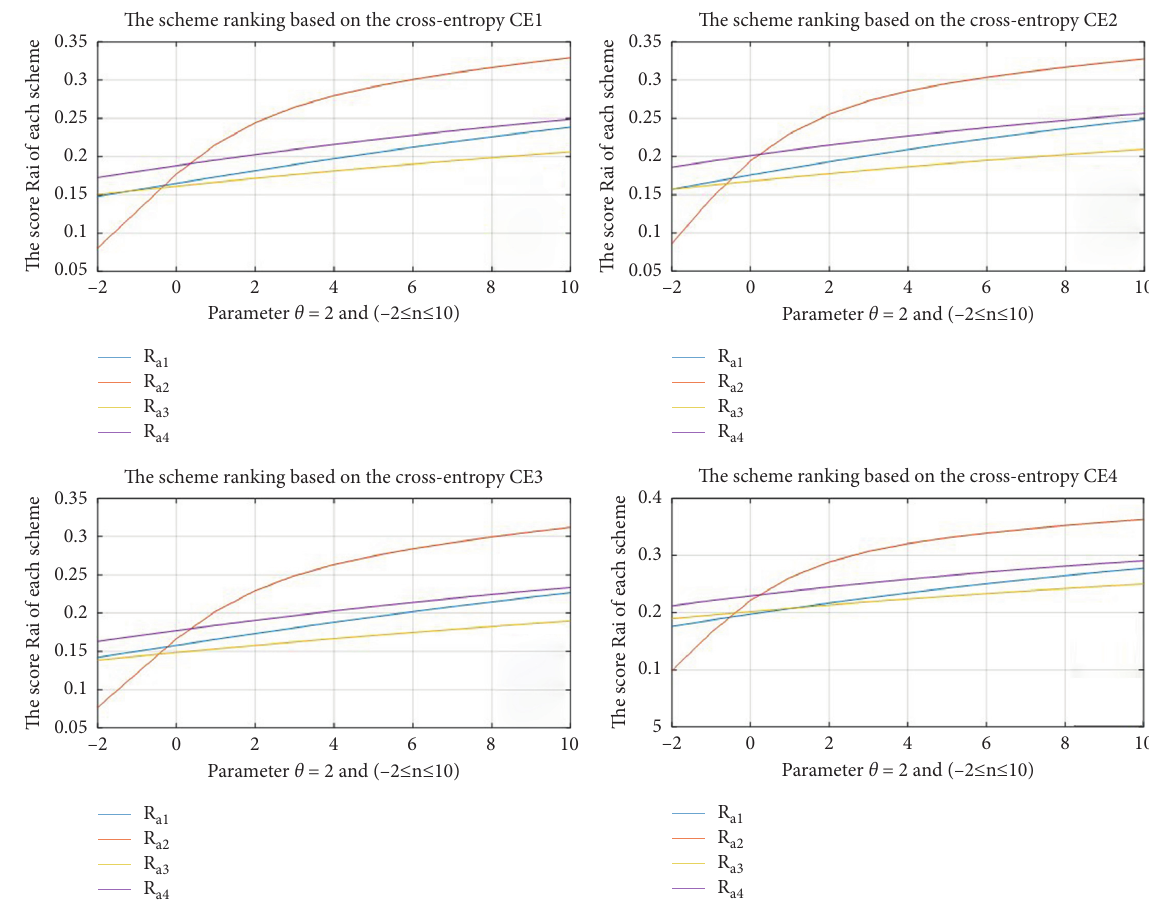
Figure 7: Ranking score of each alternative based on parameters θ � 2, − 2 ≤ n ≤